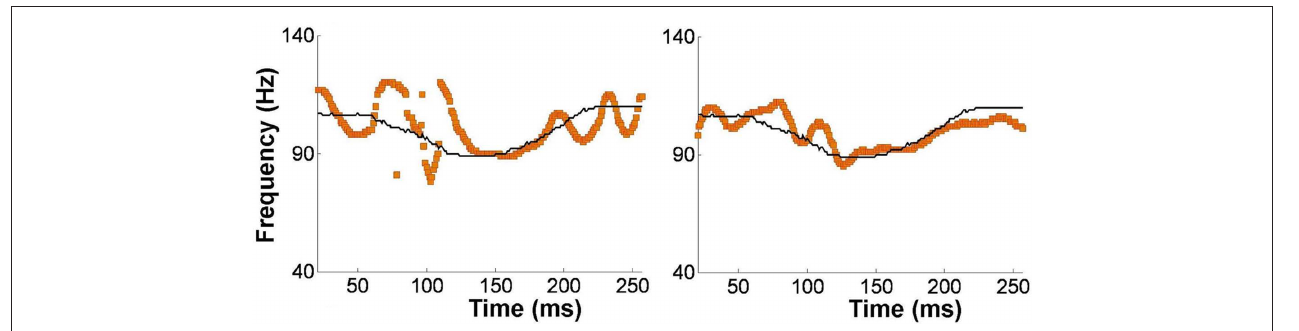
FiguRE 7 | Brainstem encoding of the fundamental frequency (F0) the Mandarin syllable /mi/ with a “dipping” (tone 3) pitch contour. The F0 contour of the syllable is shown by the thin black line, and the trajectory of FFR periodicity is shown by the yellow line. Relative to pretraining (left